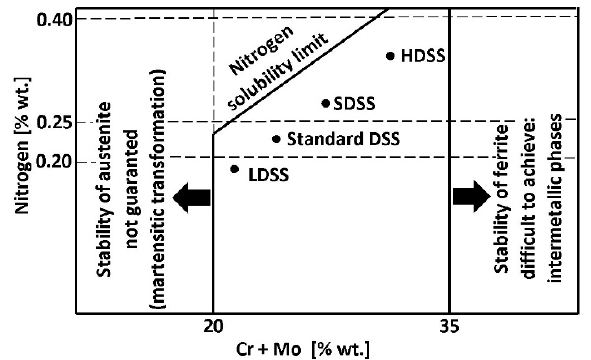
Figure 3. Stability areas of conventional duplex steels—according to [21].